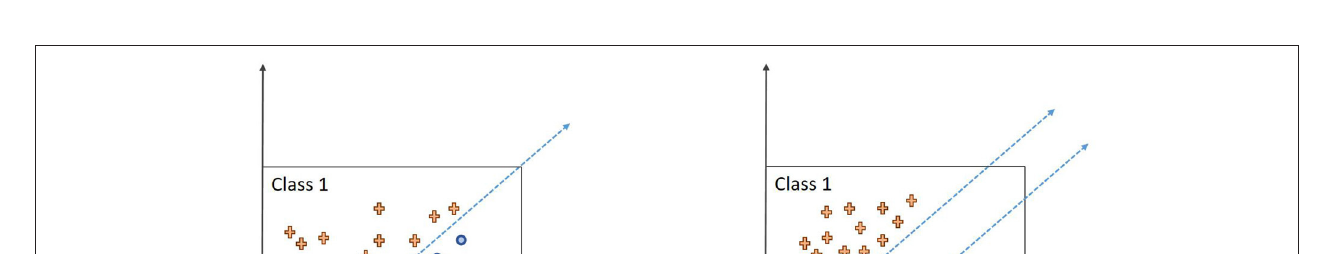
FIGURE 7 | Schematic diagram of multi-layer feature interaction and feature flow.